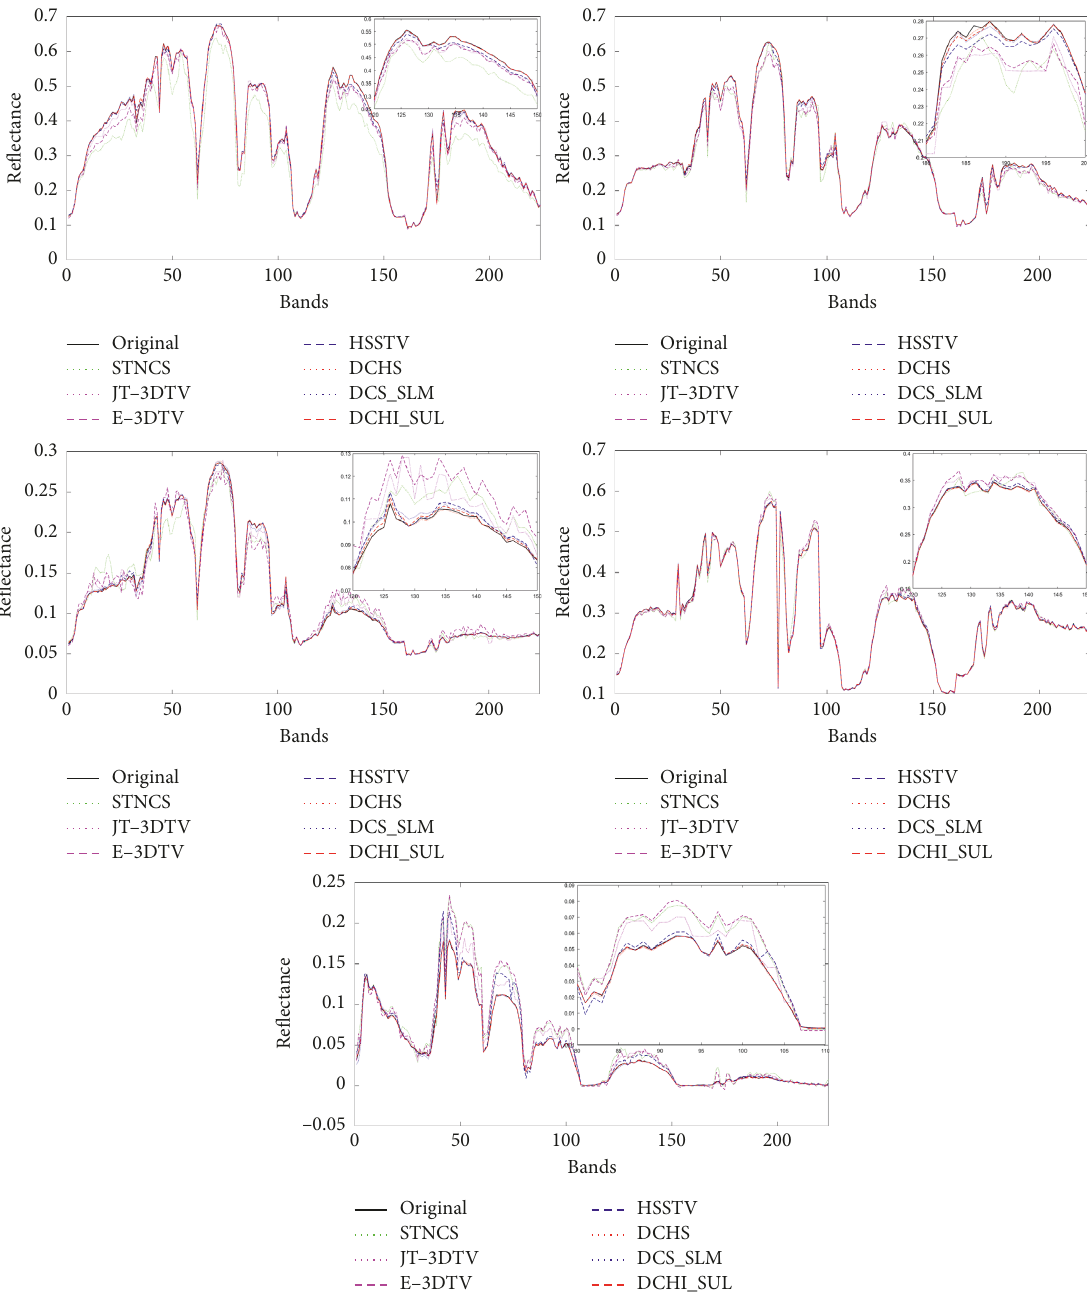
Figure 6: Original and reconstructed spectral curve at pixel (100,100) by all methods under the 0.2 sampling rate for the five HSI datasets; from top to bottom: Yellowstone 0, Yellowstone 3, Yellowstone 18, Hawaii 1, and Low